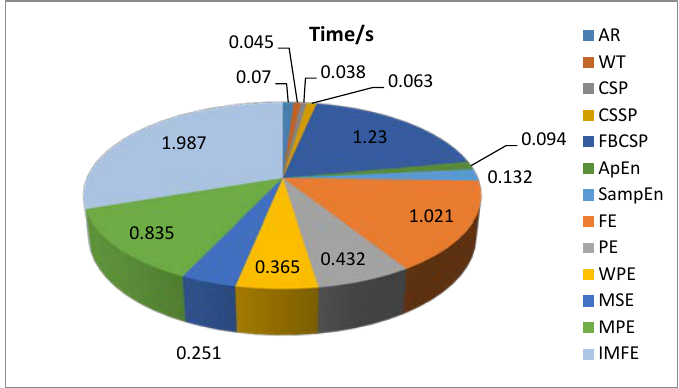
Figure 12. A comparison of time consumption using the proposed IMFE and conventional feature extraction methods.